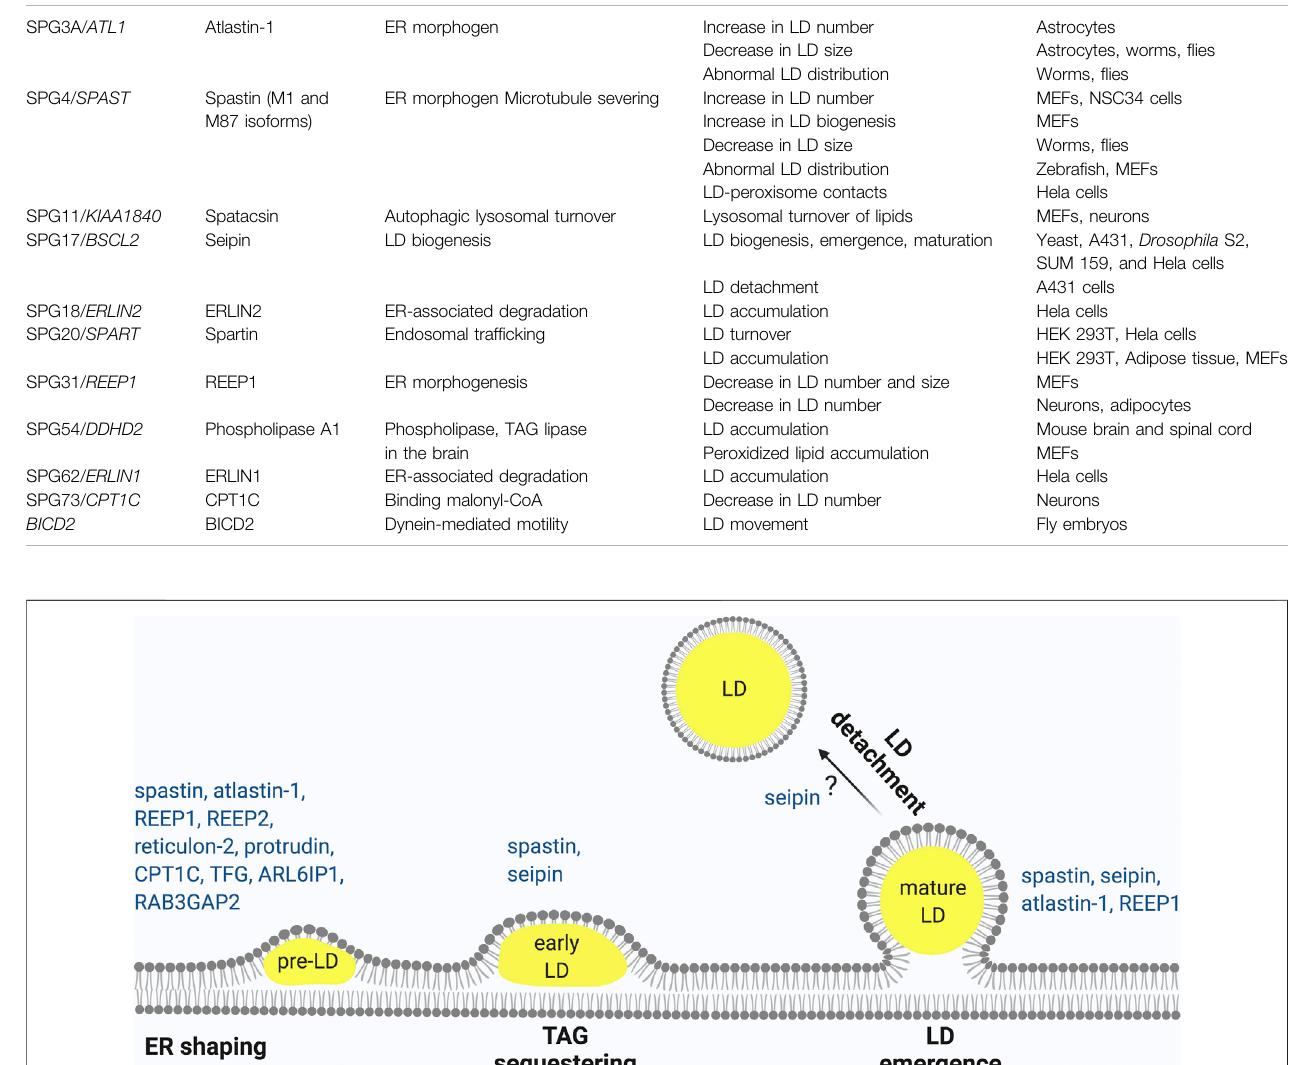
TABLE 1 | Identi fi ed spastic paraplegia (SPG) genes involved in LD metabolism. Disease/gene